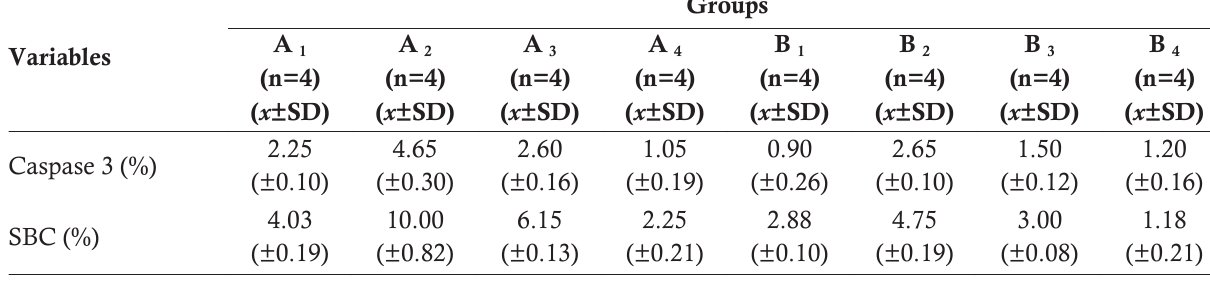
Table 1. Mean Caspase-3 Expression and Number of SBC in Balb/c Female Rats